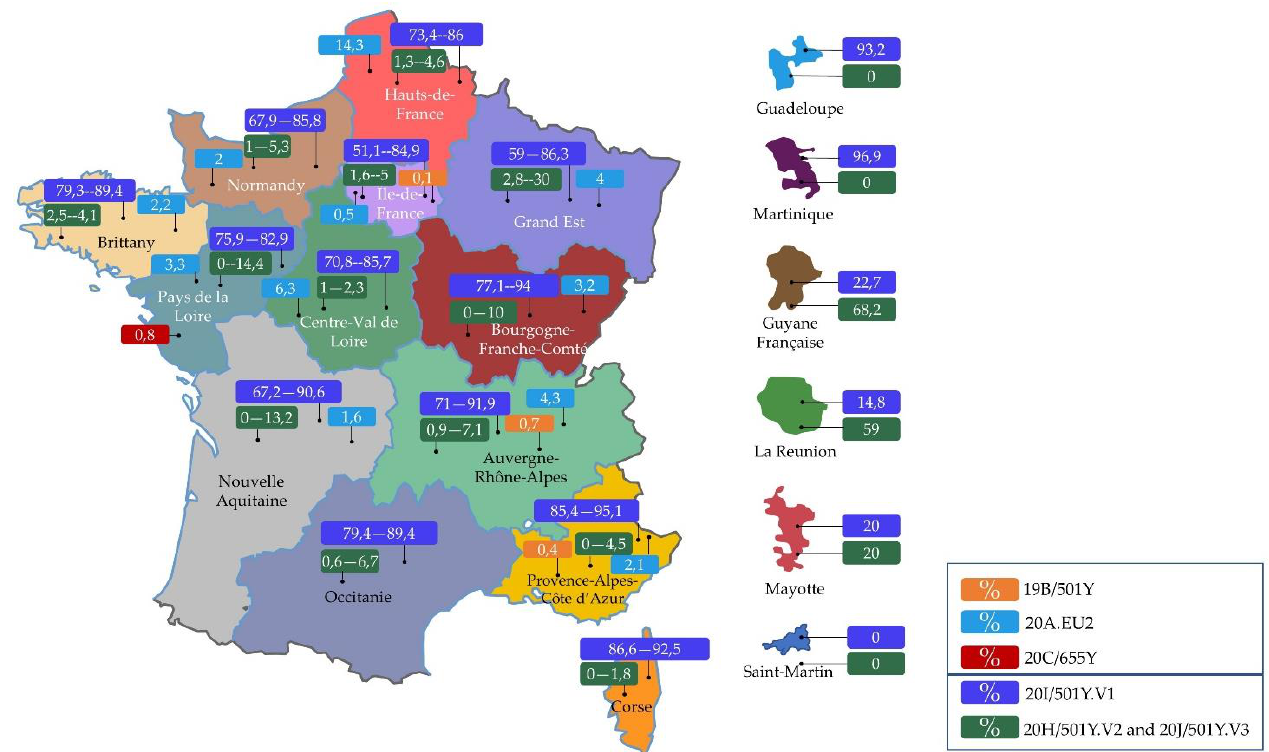
Figure 1. Percentage of three suspected variants of concern (20I/501Y.V1, 20H/501Y.V2, and 20J/501Y.V3) according to screening tests undertaken in France (7 April 2021), and percentage of 19B/501Y, 20C/655Y, and 20A.EU2 according to #5 Flash survey sequencing results (17 March 2021) [34]. (Designed by comersis) .